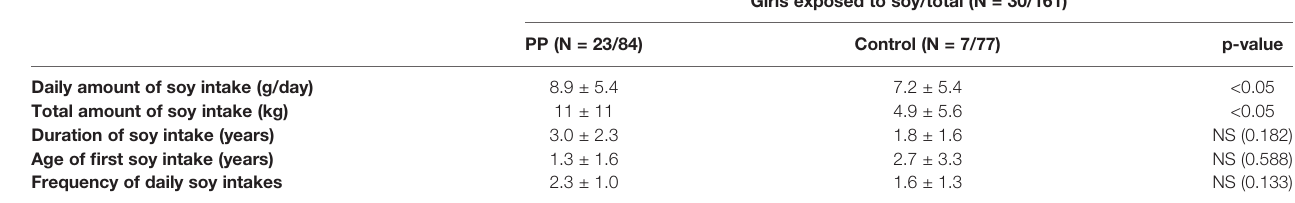
TABLE 2 | Characteristics of soy intake in females.